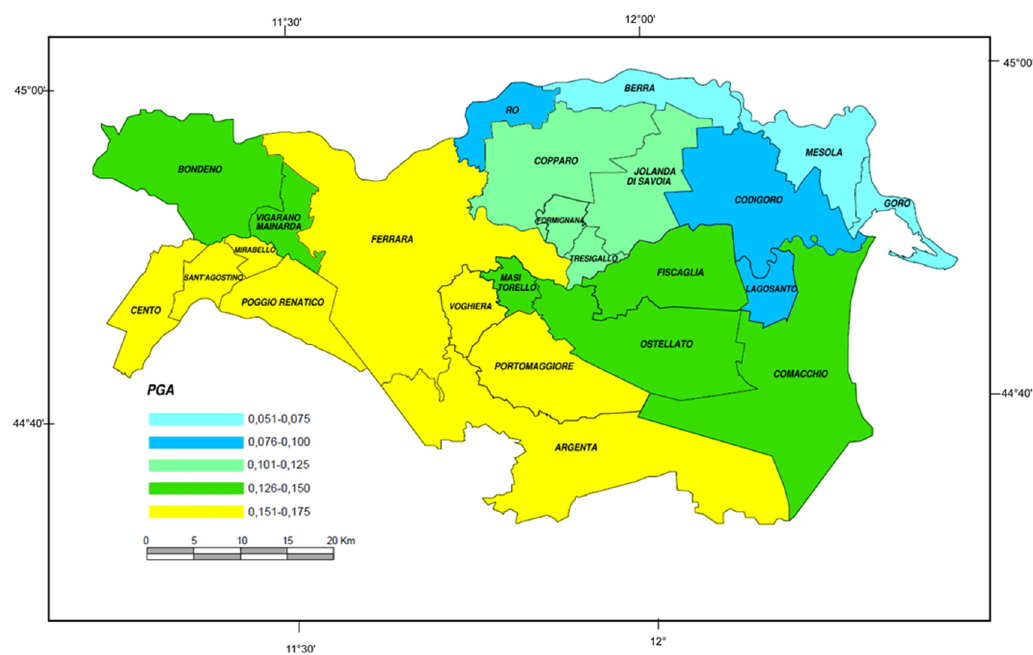
Figure 4. Map of the seismic hazard for the province of Ferrara in terms of peak ground acceleration.